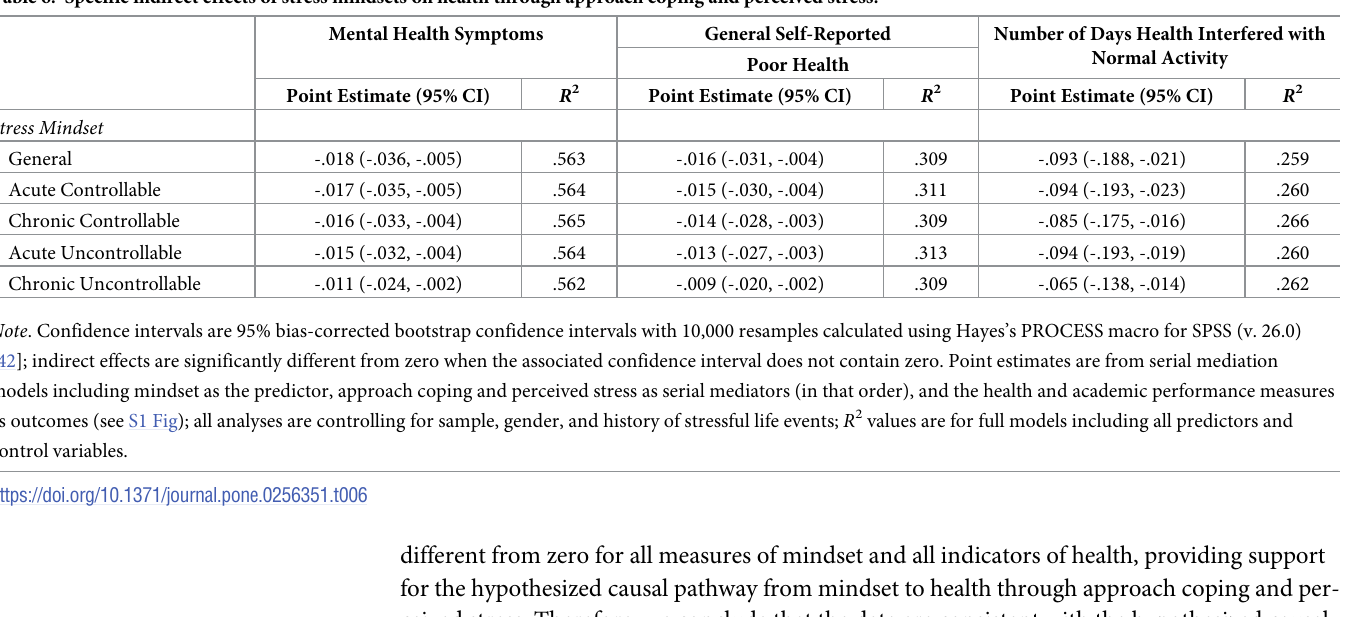
Table 6. Specific indirect effects of stress mindsets on health through approach coping and perceived